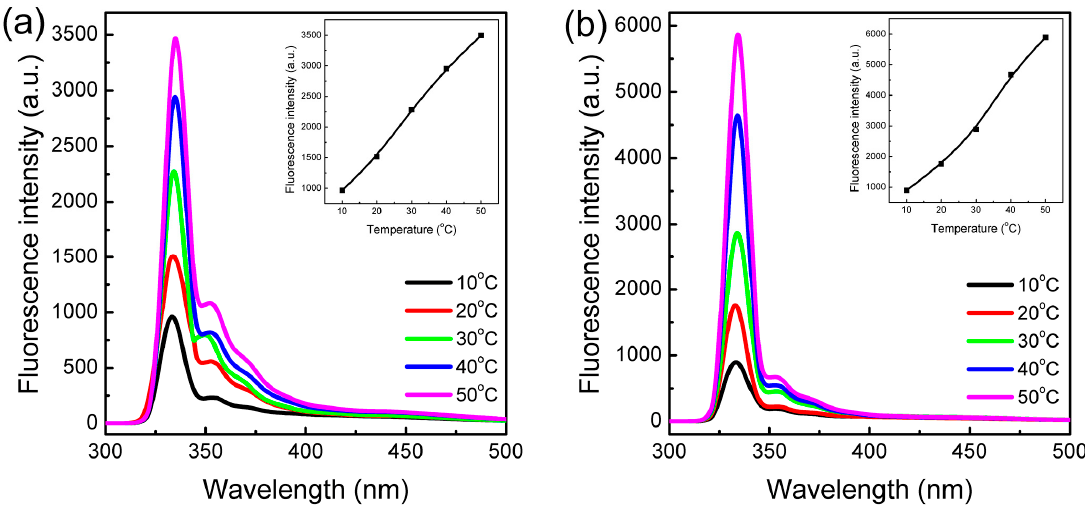
Figure 4. Fluorescence spectrum of ( a ) NOWPU-0.5 and ( b ) NOWPU-1.0 with various temperatures (concentration of NOWPUs = 10 − 3 g/mL in water, λ ex of NOWPU-0.5 = 331 nm, λ ex of NOWPU-1.0 = 332 nm).